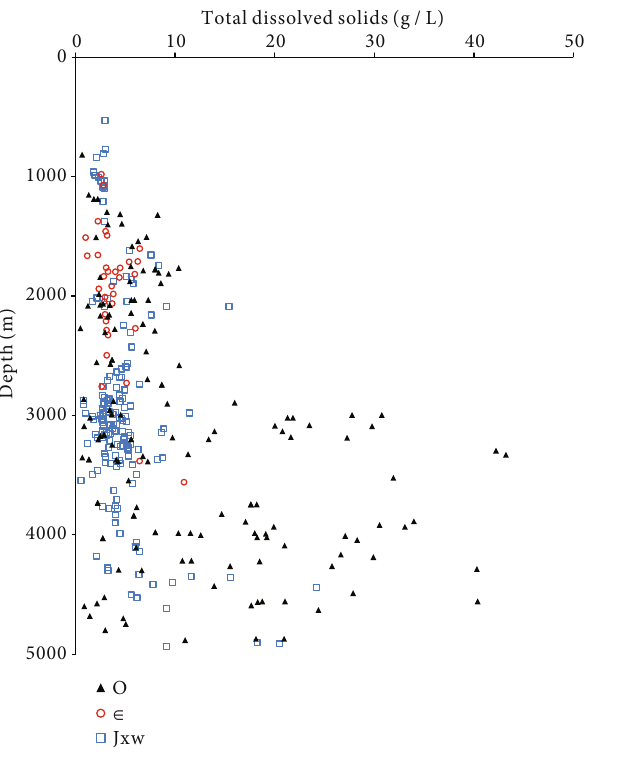
Figure 5: Depth and TDS for geothermal water in the study